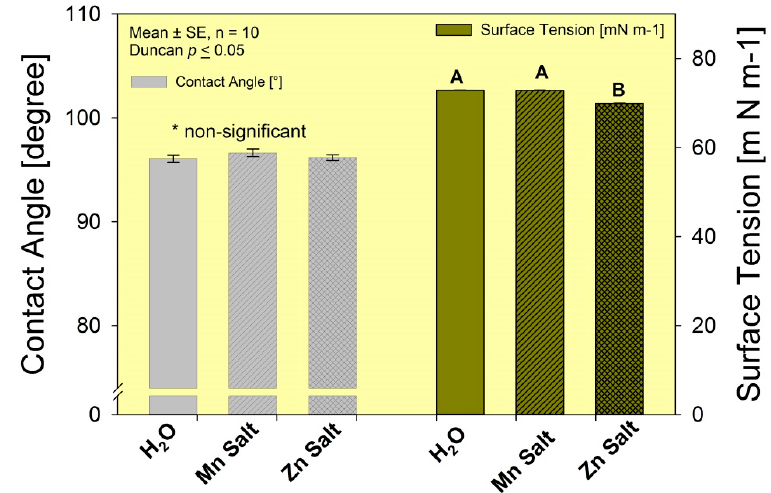
Figure 3. Surface tension and contact angle of solutions of the non-formulated Mn- and Zn-sulfate salts. Values indicate the mean (±SE; n = 10). Means were separated according to Duncan’s multiple range test ( p ≤ 0.05), values followed by different letters are statistically different.